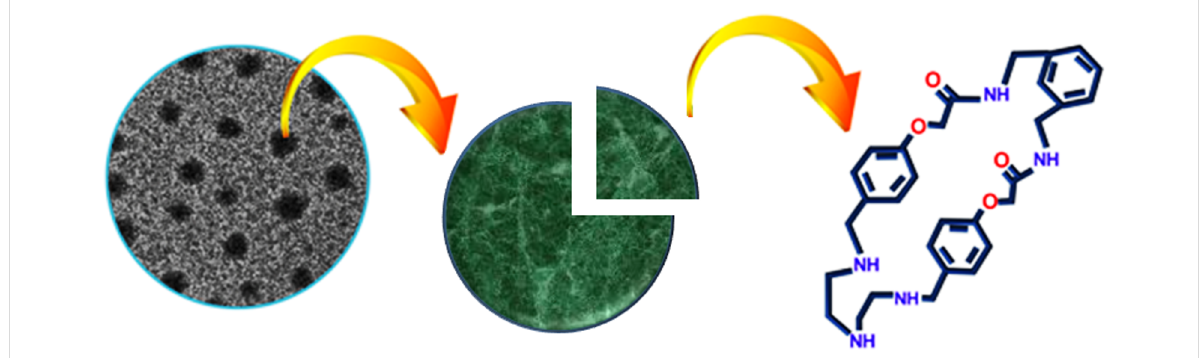
Figure 6: Representation of BATA-MC nanoreactor.